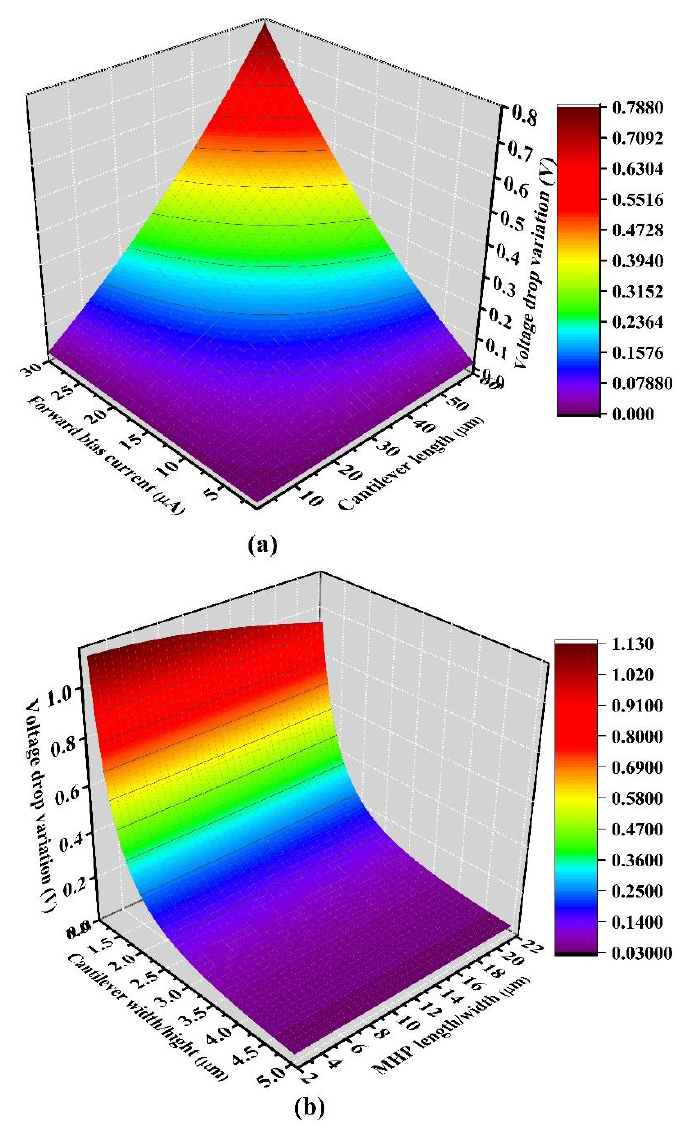
Figure 7. Temperature variation ( a ) is proportional to forward bias current, and cantilever length ( b ) is inversely proportional to length/width of the MHP and the width/thickness of the cantilever.